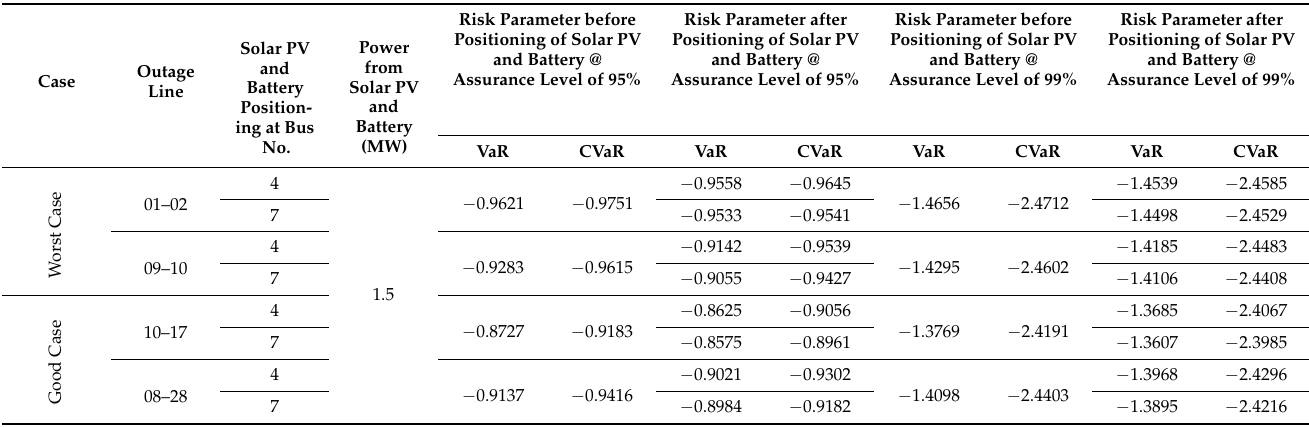
Table 10. VaR and CVaR Comparison after Installation of Solar PV and Battery with different assurance level in IEEE 30-bus